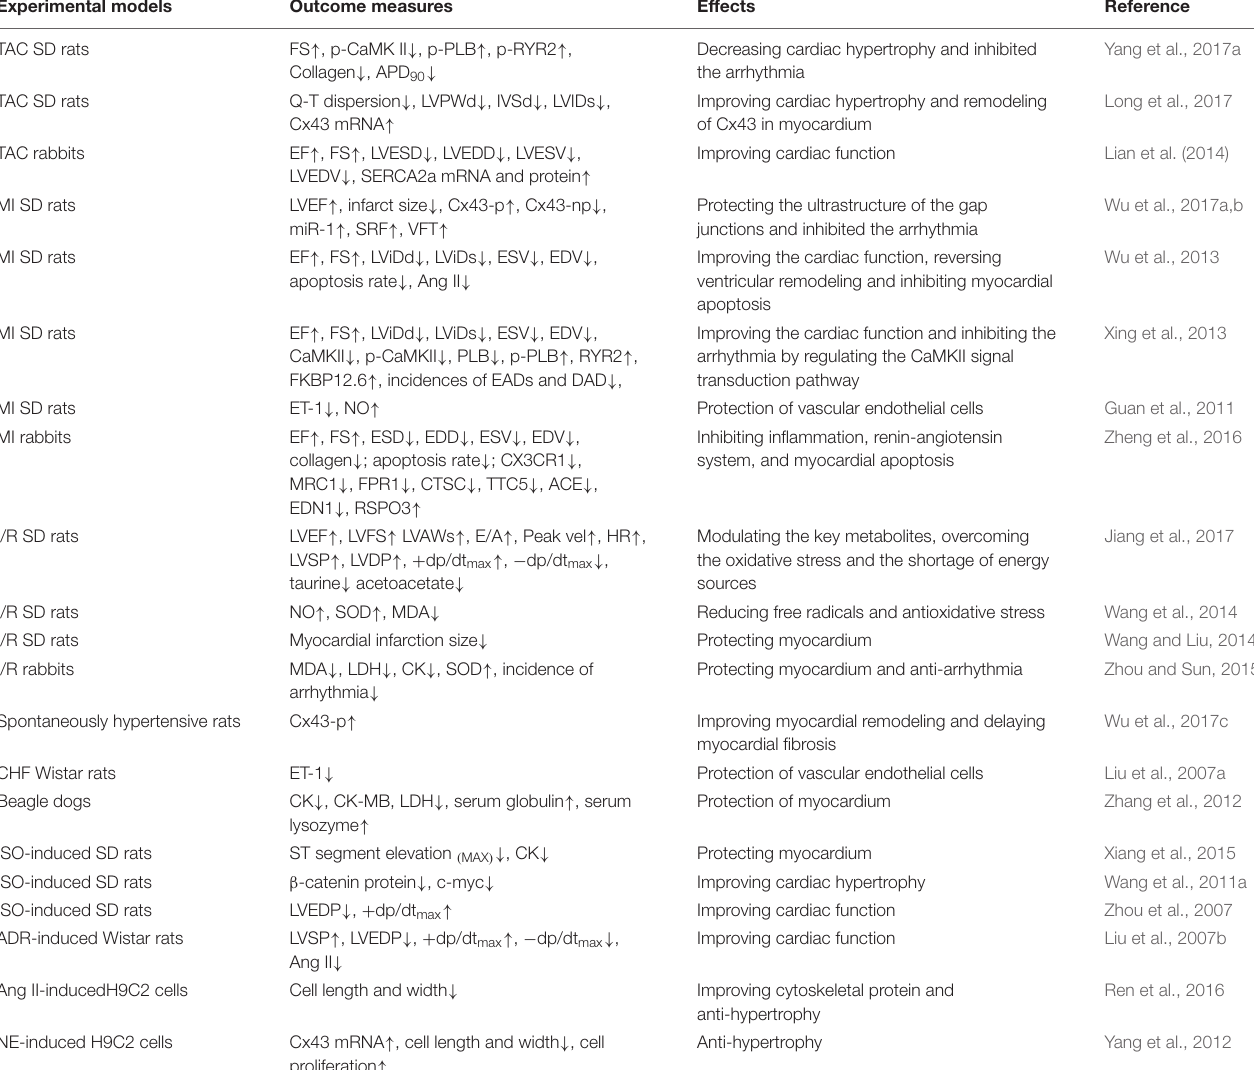
TABLE 1 | The cardioprotective effects of